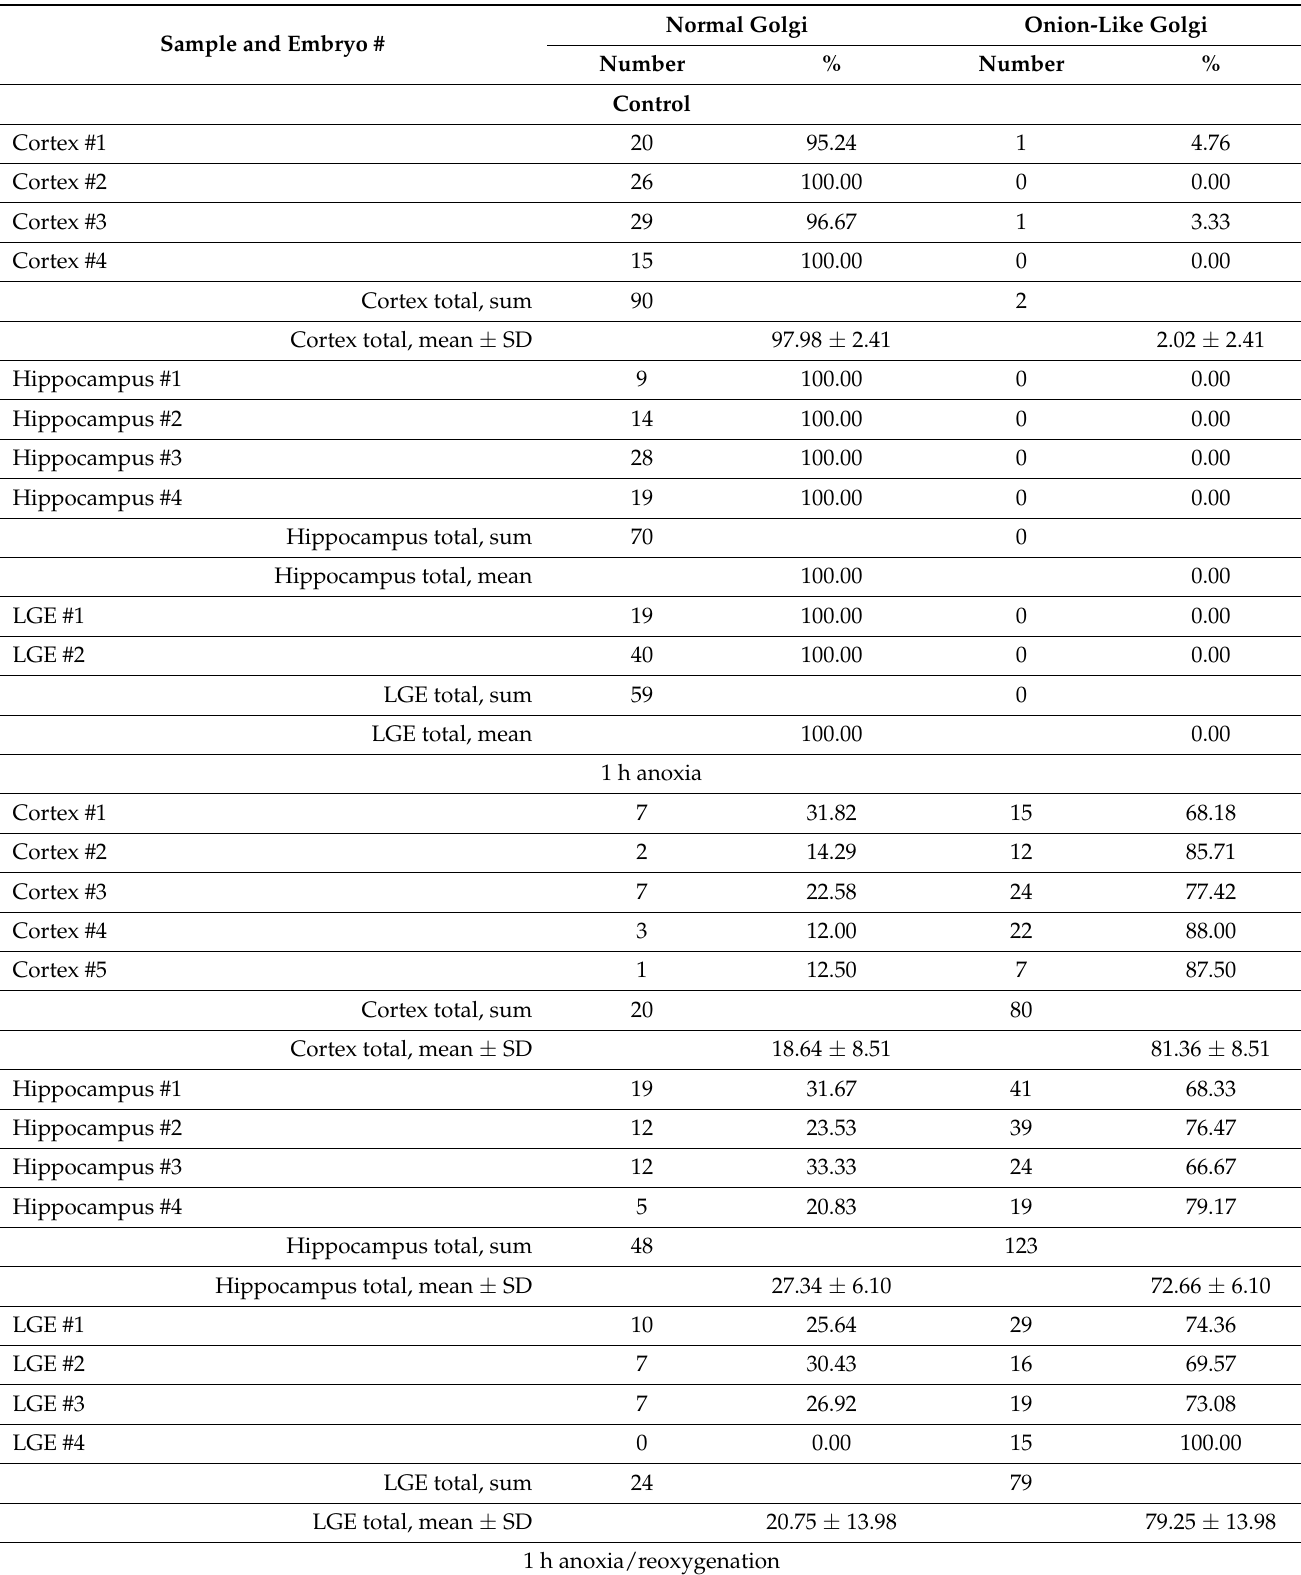
Table 1. Quantification of normal and onion-like GA in E13 mouse embryo brain in control, anoxic, and reoxygenation